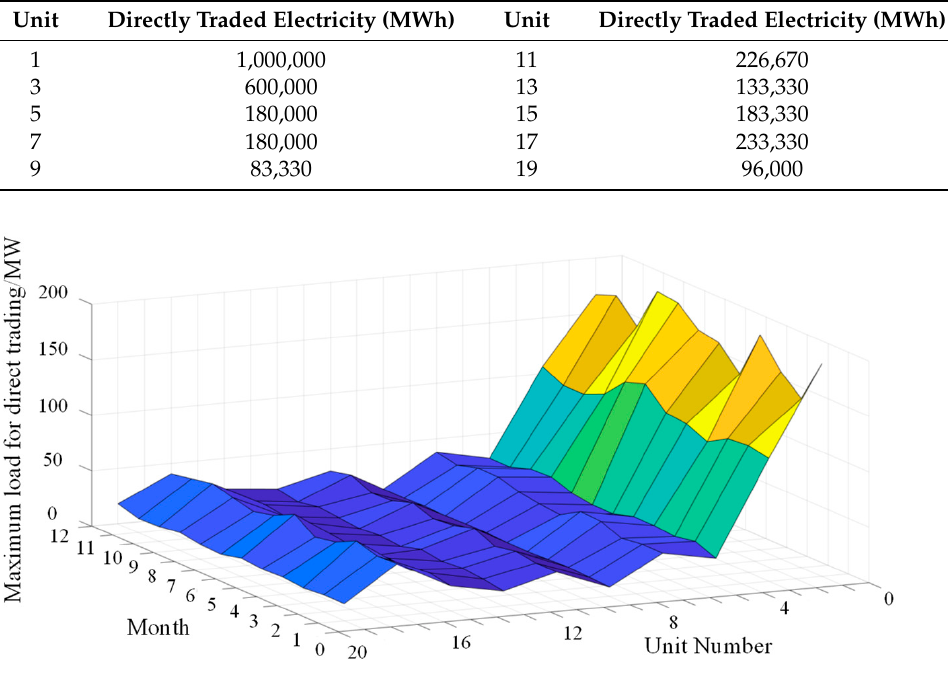
Figure 5. Maximum load of the Direct trading consumer.